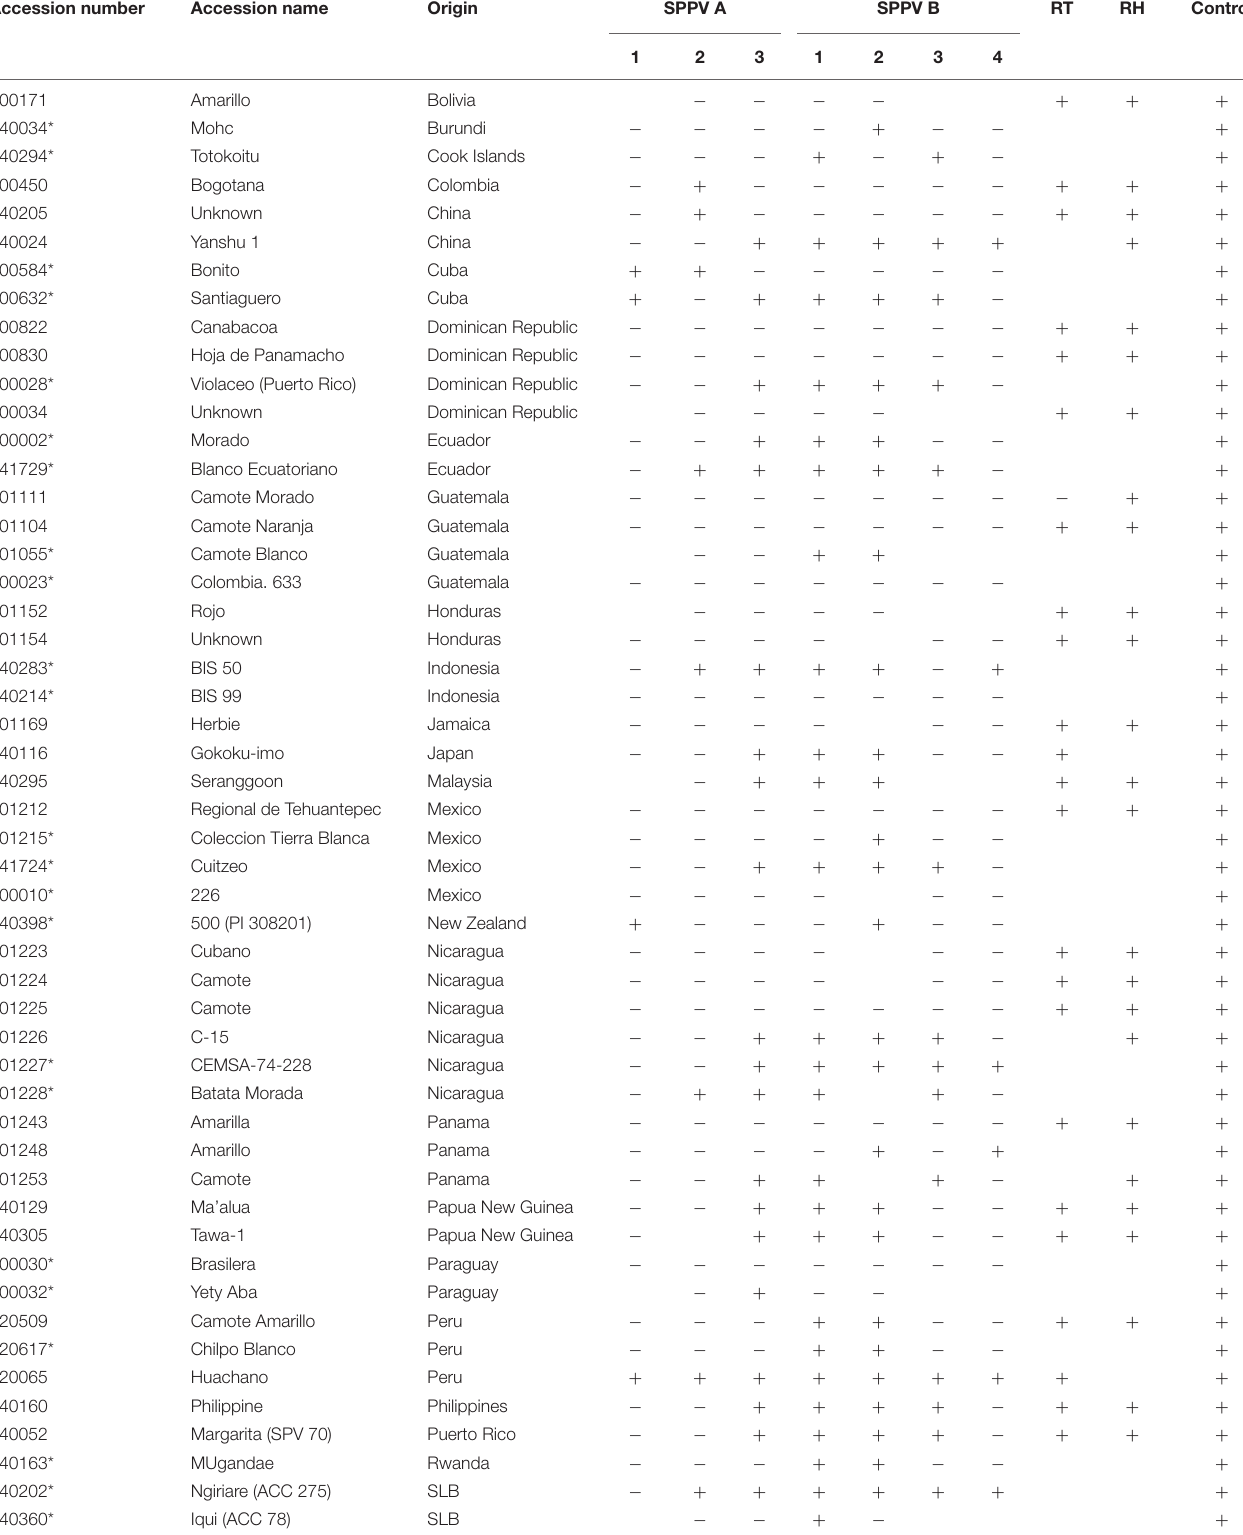
TABLE 2 | List of accessions used in this study and results of PCR tests for specific regions of SPPV-A and SPPV-B and degenerate